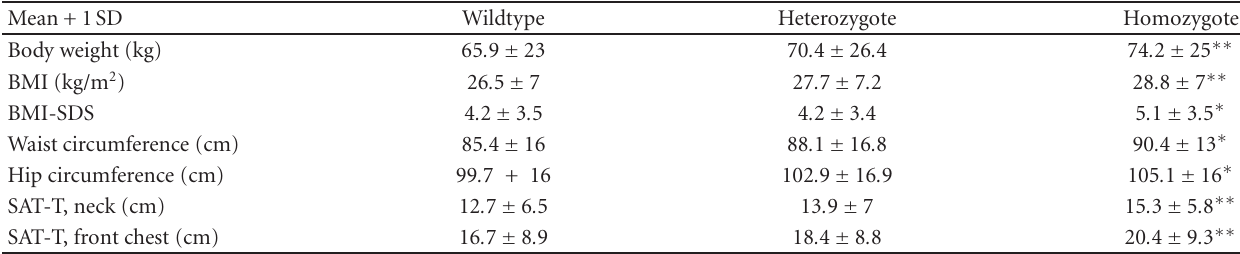
Table 3: Associations of clinical parameters with the rs9939609 FTO gene polymorphism.